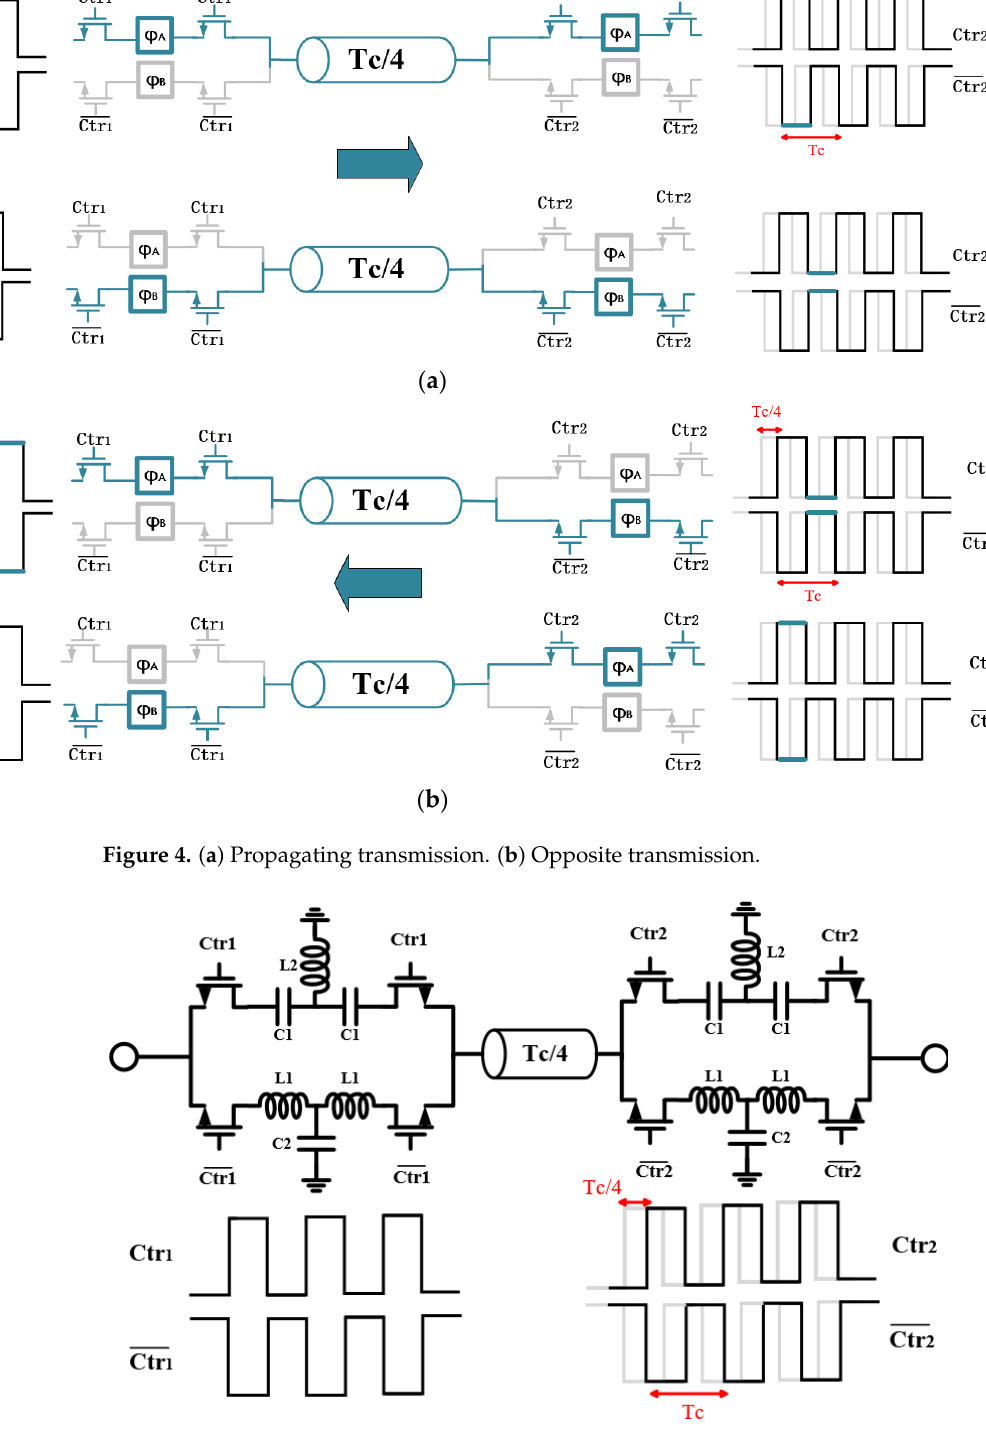
Figure 6. The phase difference between the forward and the reverse transmissions. In fact, when 𝑇 𝑚 ∕ 𝑇𝑐 is odd, the phase change of the output of the two ports is ±90 0 , respectively. Figure 7 shows the phase change caused by the periods of the control signals. When the value of 𝑇 𝑚 ∕ 𝑇𝑐 is 5, the scattering matrix of the gyrator in a time- harmonic form satisfies the following relationships: 𝑆 12 = 𝑗, 𝑆 21 = −𝑗 .